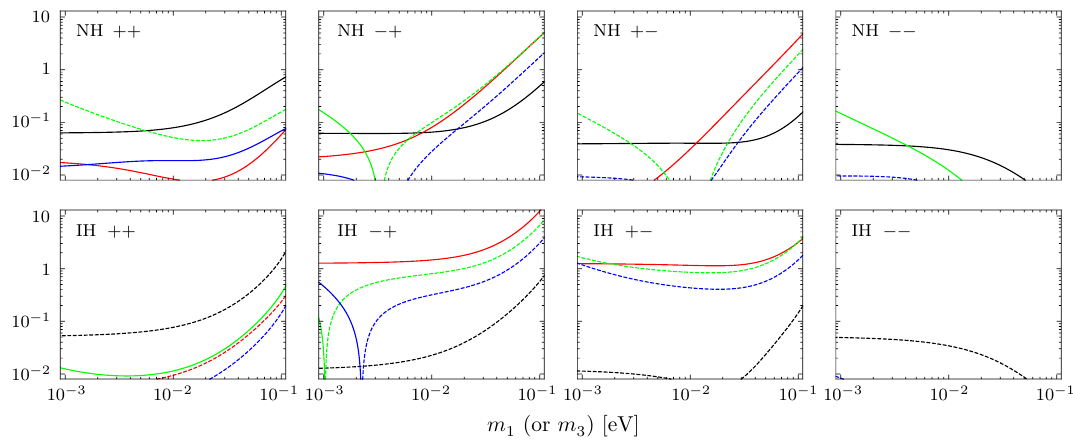
= 0 : 1 ((cid:1) (cid:18) in black, (cid:1) (cid:14) in red, (cid:1) (cid:26) in 2 (or m ) in the NH (or IH) case for 1 3